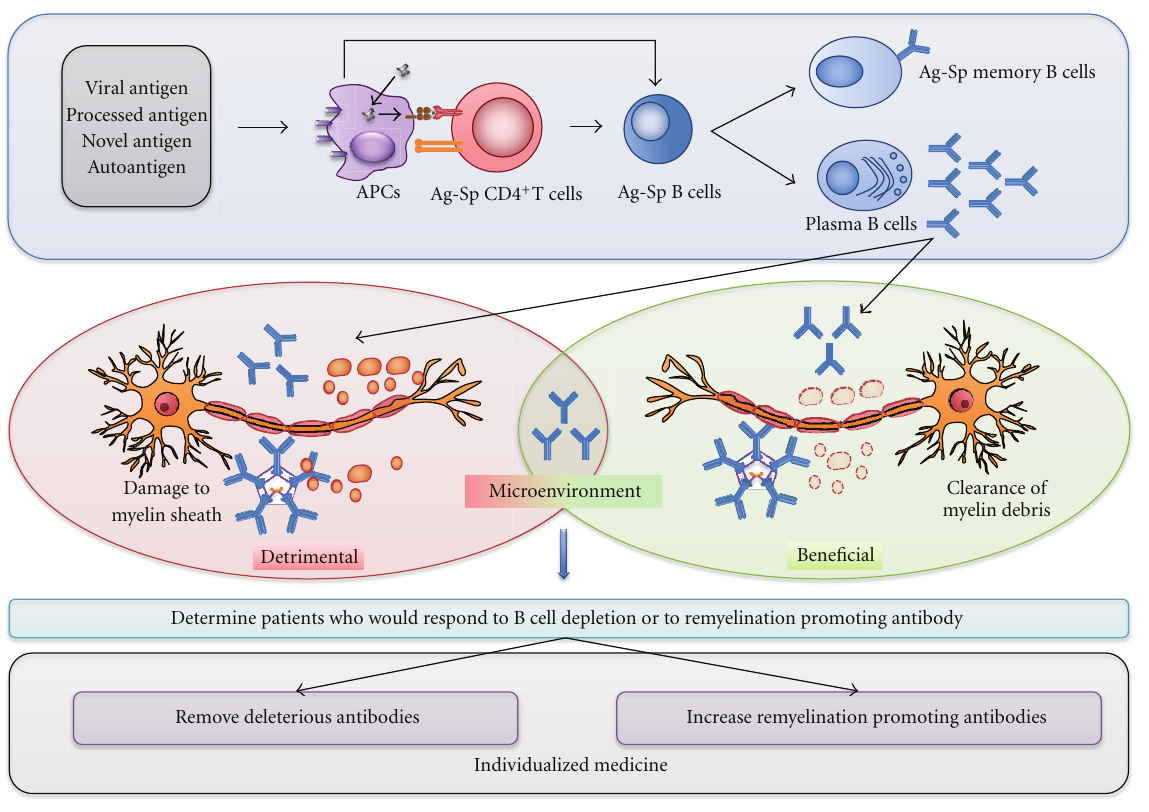
Figure 2: The role of B cells in MS pathogenesis. Antigens (viral, processed, novel, or auto) are internalized and presented via antigen presenting cells (APC’s, such as dendritic cells, microglia and other mononuclear phagocyte system cells) to antigen-specific na¨ıve T cells and/or B cells. B cells can sometimes act as APC’s. Activated B cells undergo clonal expansion and mature into either antigen-specific memory B cells or into plasma cells that secrete antigen-specific antibodies that may have a detrimental (further damage to myelin sheaths of axons) or a beneficial e ff ect (remyelination, clearing the metabolic wastes away, and neurite extension), depending on the microenvironment. The oligoclonal immune response observed in patients with MS thus represents an ambivalent role. It is of priority to determine clinical assays to delineate patients who would respond to B cell depletion therapies, or to remyelination promoting antibody therapy. This approach supports the concept of “individualized medicine”, where deleterious antibodies would be removed from circulation or in other cases endogenous remyelination would be